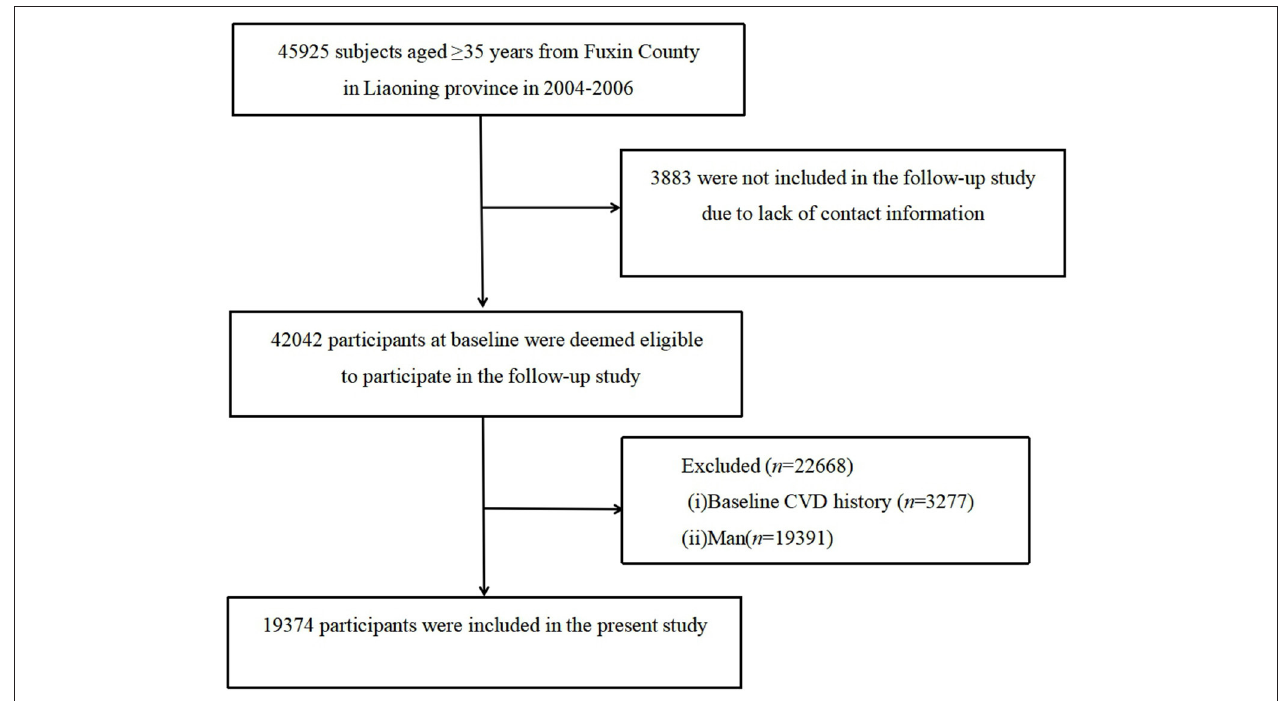
FIGURE 1 | The inclusion and exclusion criteria for the study